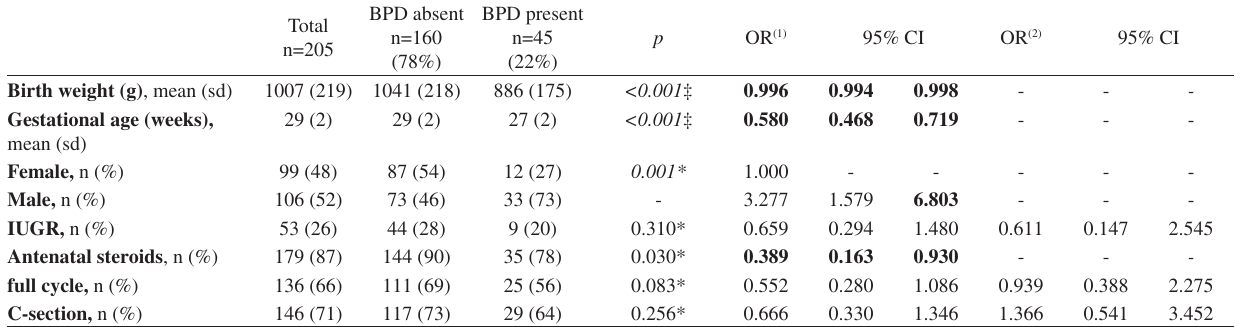
Table 1 - Demographics of the studied population (n=205).